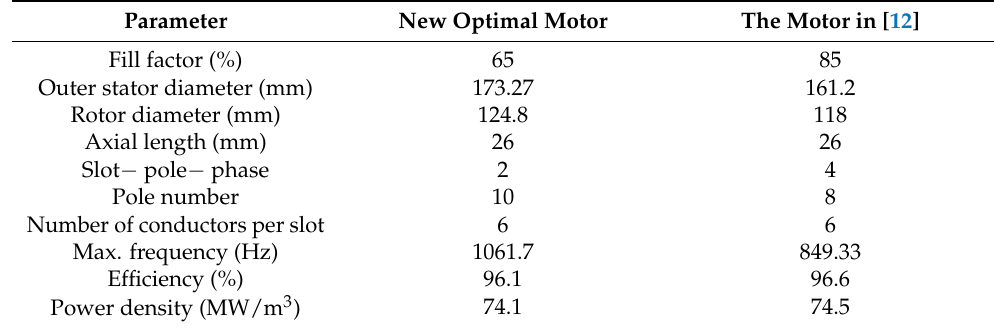
Table 2. Design summary of the PMSM and comparison versus the previous design [12].